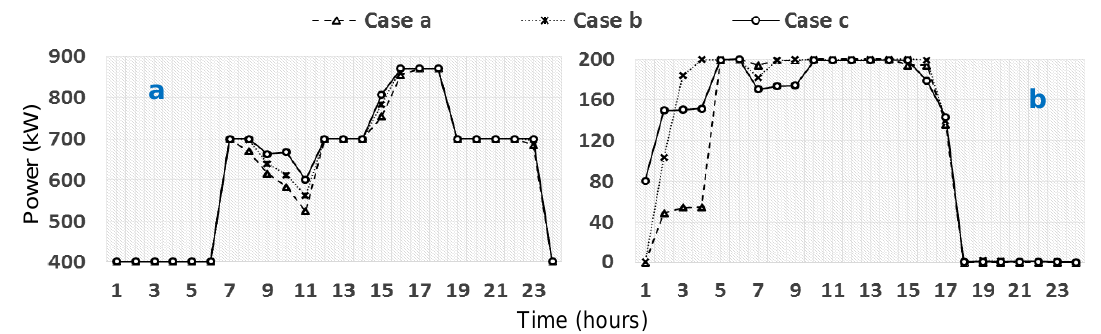
Figure 8. ( a ) Collective generation amount of Controllable generators (CGs); and ( b ) Cumulative state of charge (SOC) of battery energy storage system (BESSs).